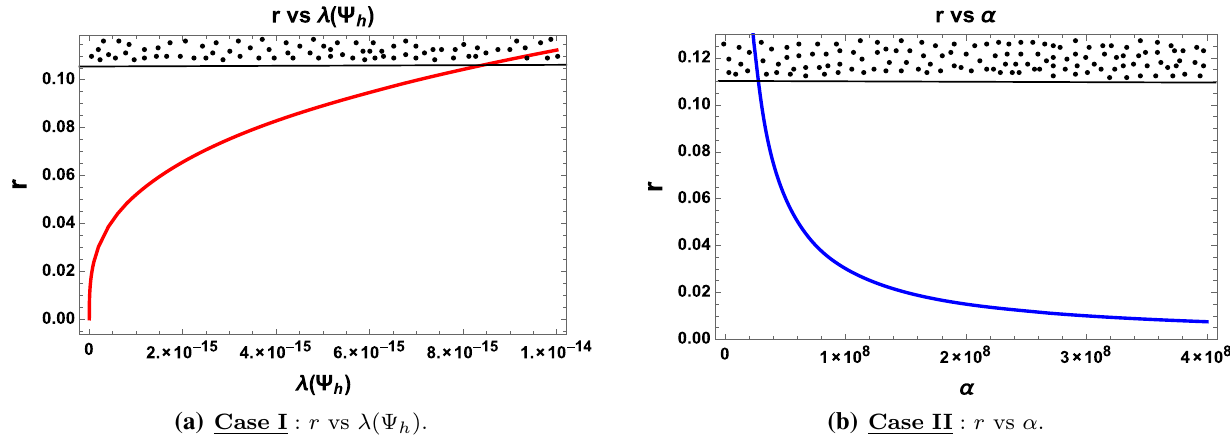
Fig. 7 Variation of the tensor-to-scalar ratio r with respect to a coupling parameter λ((cid:4) h ) (Case I) and b scale free parameter α (Case II). For both plots the dotted region is disfavored by Planck 2015 data along with BICEP2+Keck Array joint constraint [44–46]